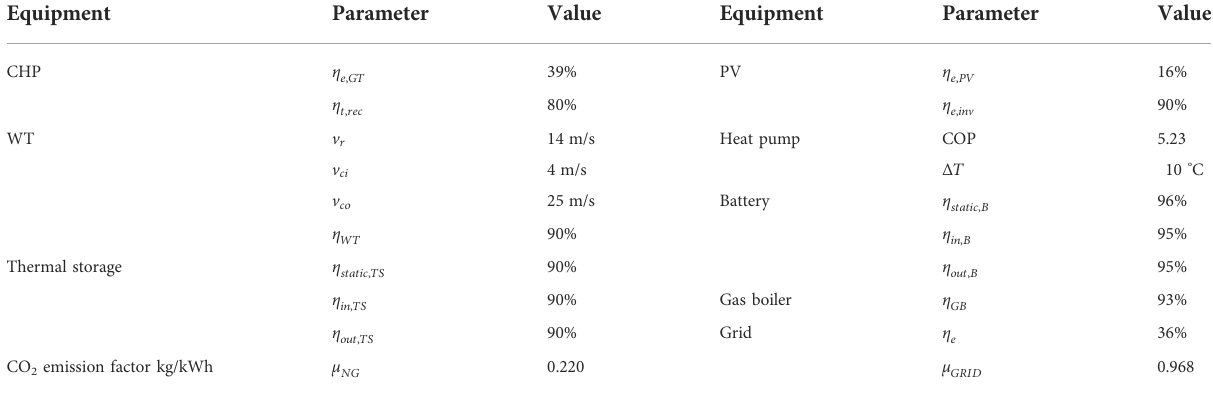
TABLE 1 Technical and emission parameters (Ren et al., 2019; Ruhnau et al., 2019).